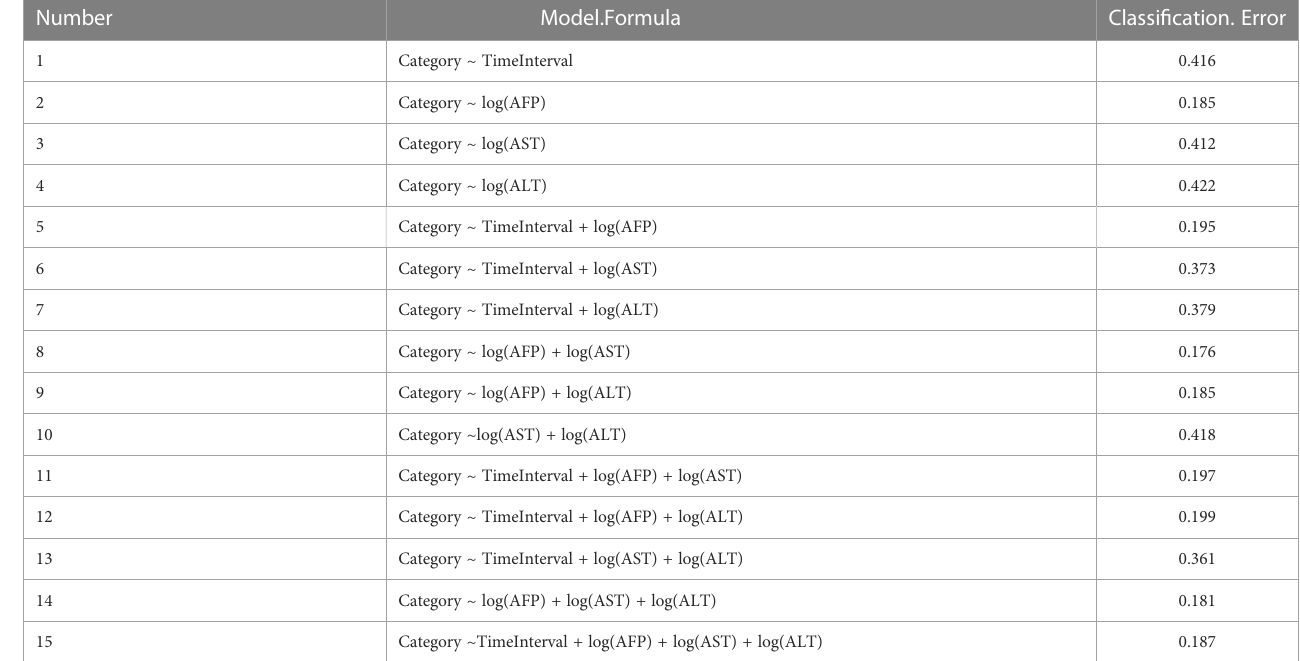
TABLE 2 Subset Selection by LOOCV. Number